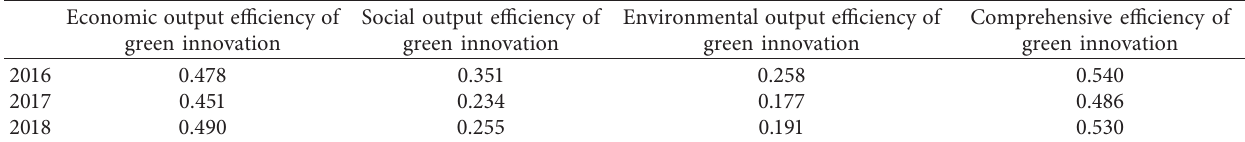
Table 3: Green innovation efficiency of China’s listed energy companies during 2016–2018 (stage I).